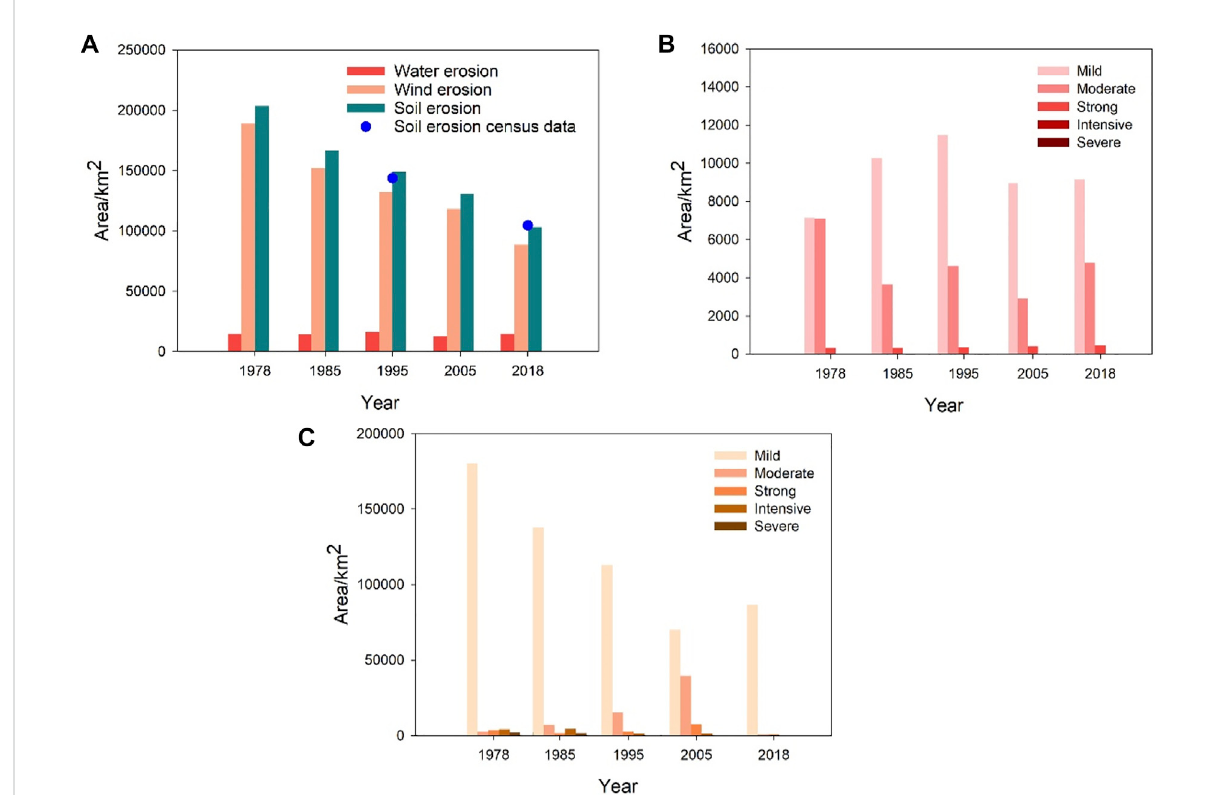
FIGURE 3 (A) SoilerosionareaandvalidationinNortheastInnerMongoliafrom1978to2018.Theareachangeofwatererosion (B) andwinderosion (C) in Northeast Inner Mongolia from 1978 to